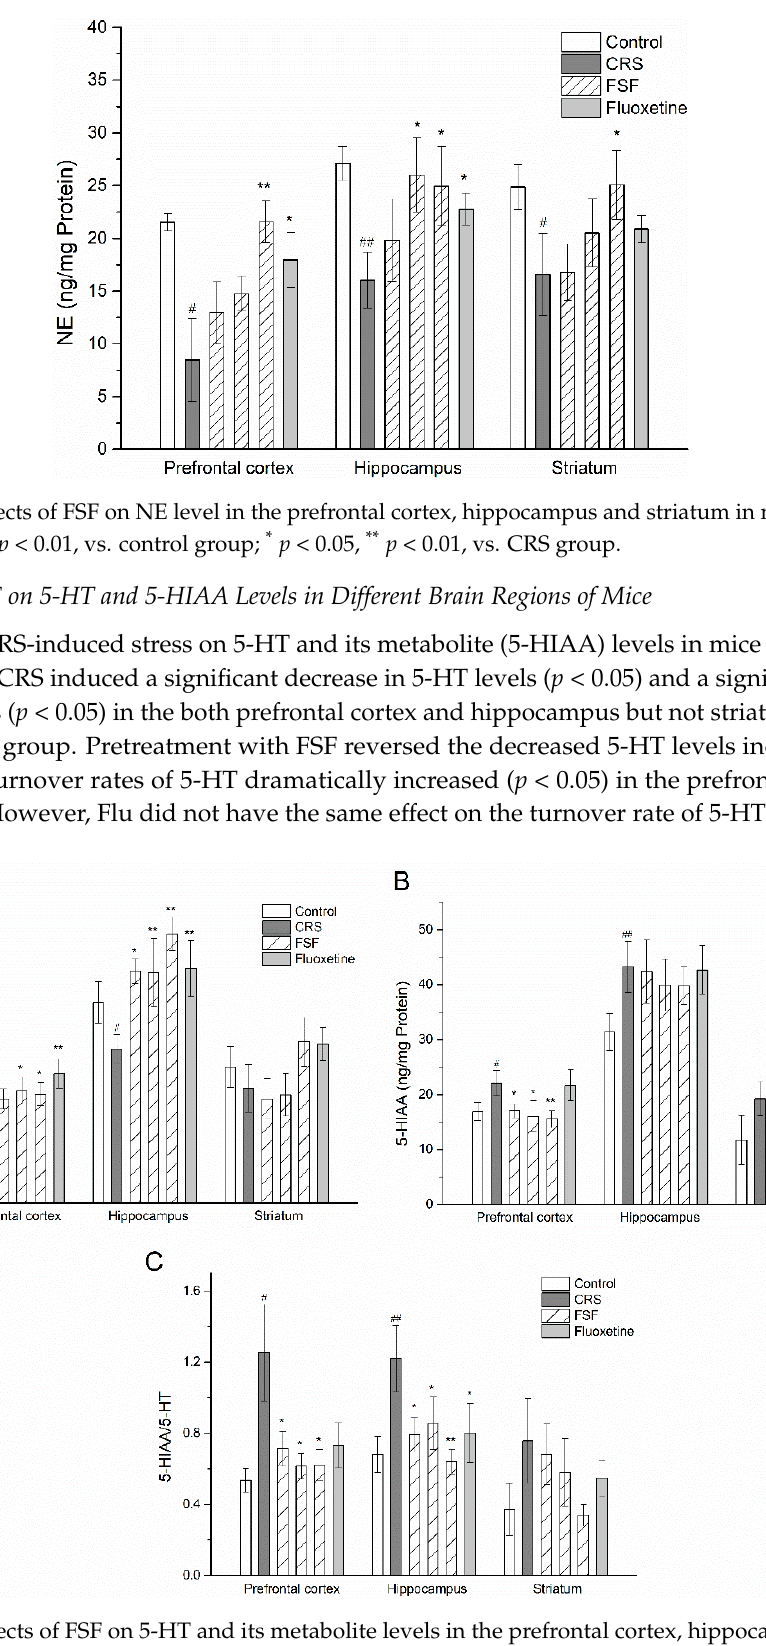
Figure 7. Effects of FSF on 5-HT and its metabolite levels in the prefrontal cortex, hippocampus and striatum in mice. ( A ) The level of 5-HT. ( B ) The level of 5-HIAA. ( C ) The rate of 5-HIAA/5-HT. n = 6, # p < 0.05, ## p < 0.01, vs. control group; * p < 0.05, ** p < 0.01, vs. CRS